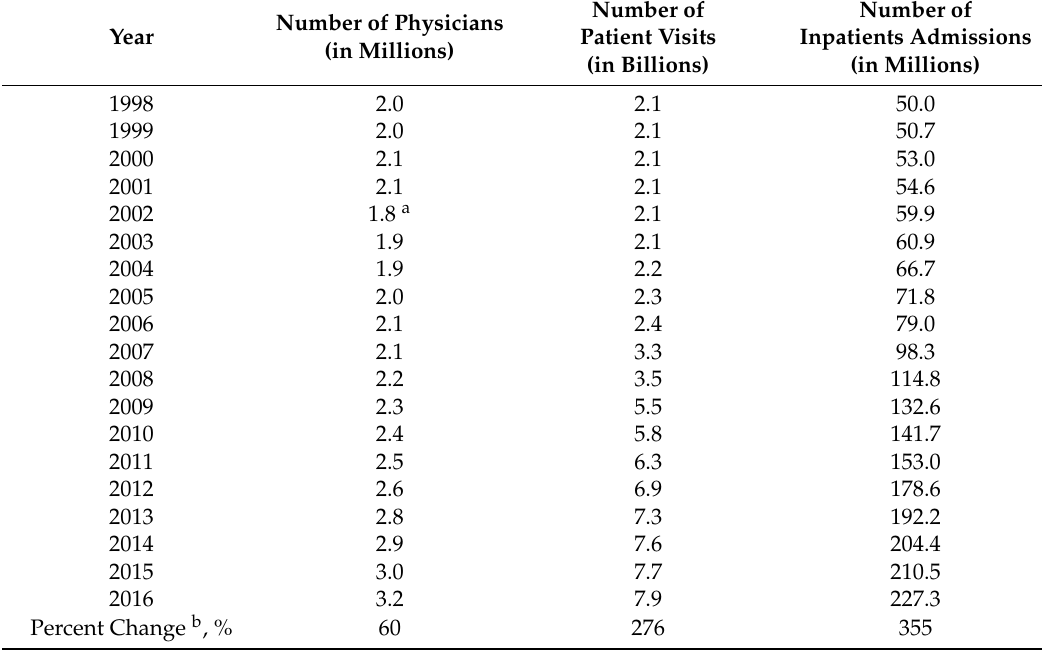
Number of physicians, patient visits and inpatient admissions in Chinese health institutions,